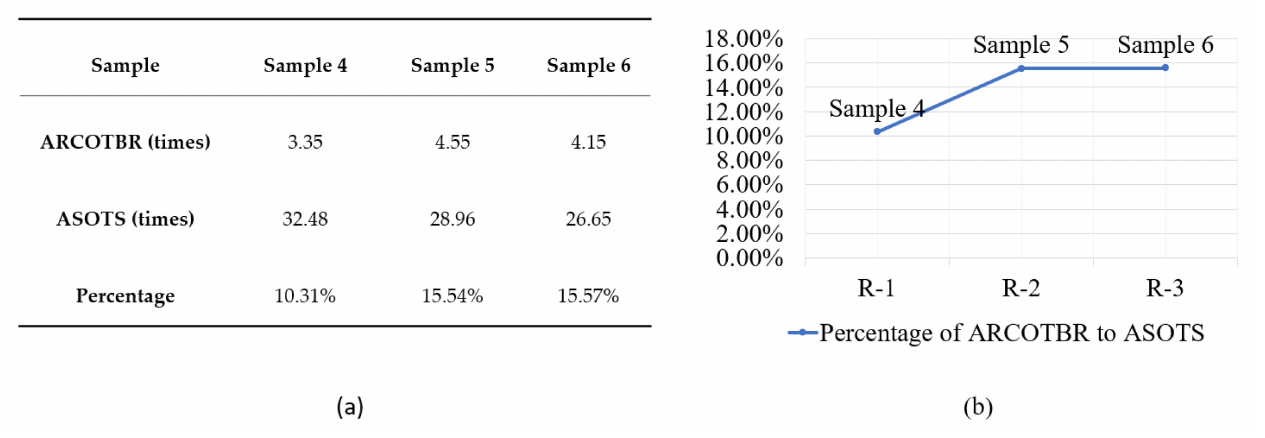
Figure 10. Analysis of fixation trajectory in experiment 2: ( a ) Relevant data for fixation trajectory in Experiment 2 and ( b ) relationship between the percentage of ARCOTBR to ASOTS, and the S/L ratio (the experiment 2).